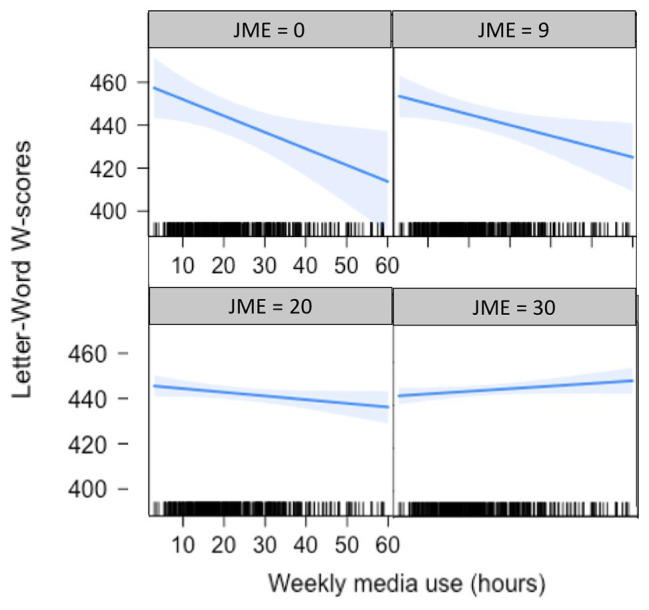
Association between weekly media use and literacy gains, moderated by joint media engagement (JME). Each panel represents a different level of joint media engagement score, starting from a low score of 0 on the top left, going to a high score of 30 on the bottom right.